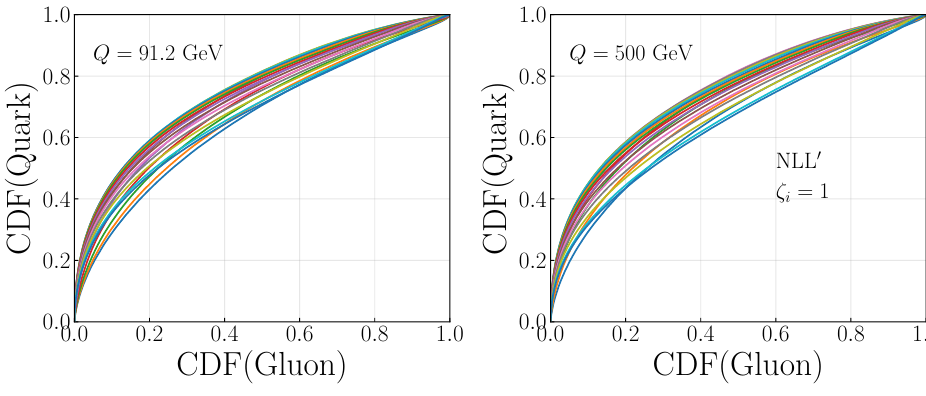
Figure 14 . ROC curves for quark/gluon jet discrimination with leading (sub)jets for different values of the jet radius R and two different values of the energy scale Q